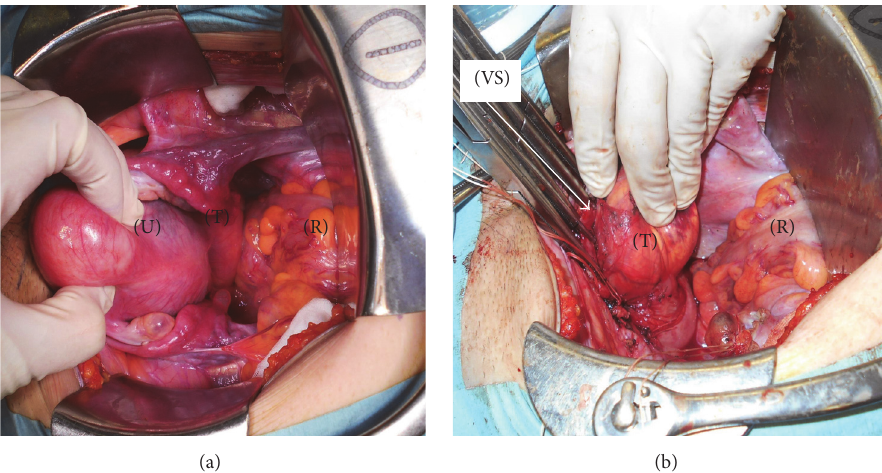
Figure 4: (a) Laparotomy findings. A pelvic tumor (T) was not connected to the uterus (U). (b) Laparotomy findings after an abdominal hysterectomy and a bilateral salpingectomy. A pelvic tumor (T) was connected to the vaginal stump (VS), but not the rectum (R).